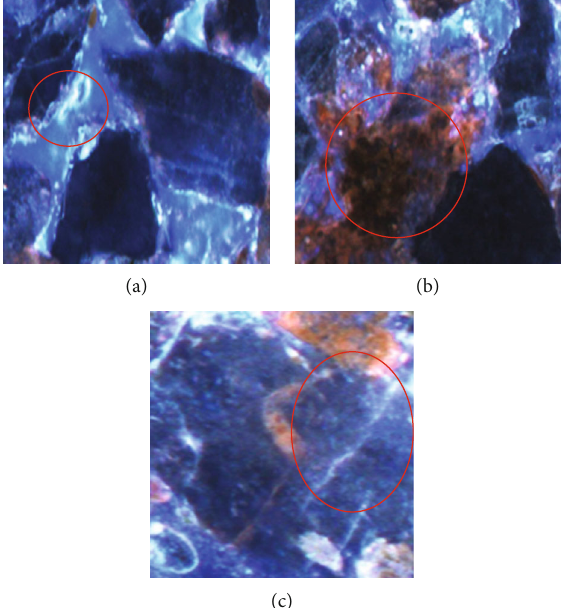
Figure 9: Residual oil in bound state. (a) Hole surface fi lm. (b) Particle adsorption. (c)